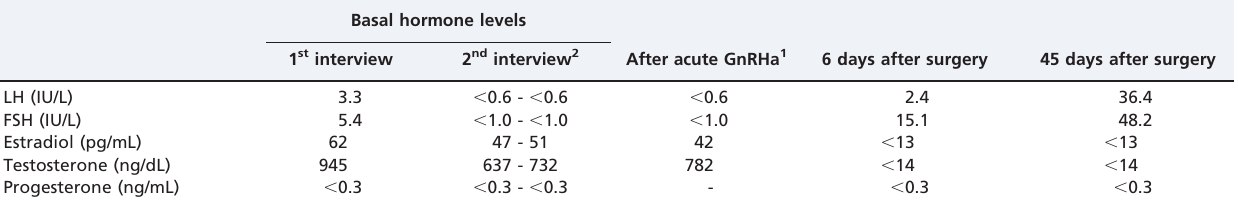
Table 1 - Hormone levels under basal and dynamic condition and after surgery. Basal hormone